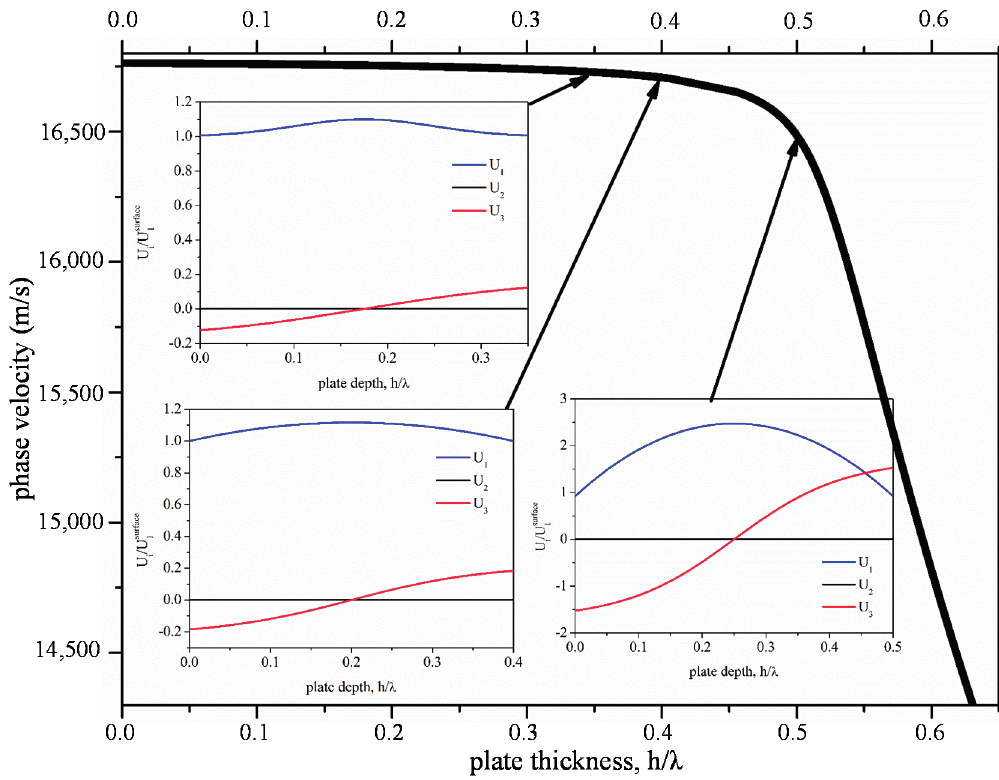
Figure 1. Phase velocity of the S 0 mode vs. h BN / λ ; the insets show the acoustic field profile for h BN / λ = 0.35, 0.4 and 0.5.